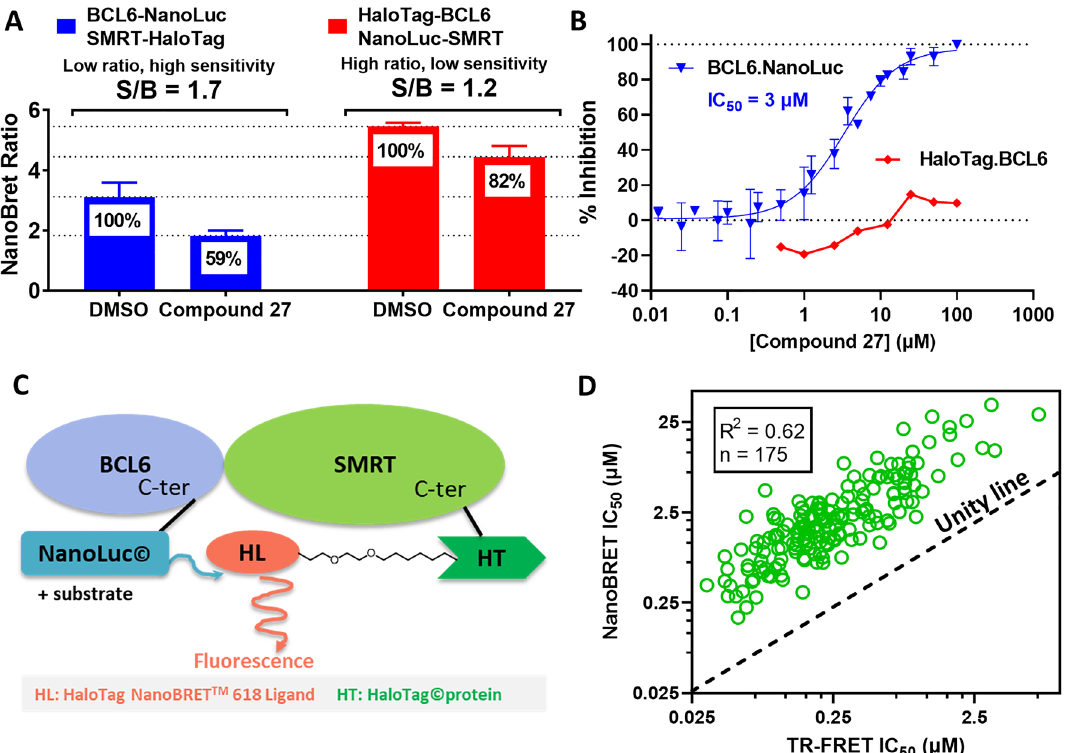
Figure 7. NanoBRET assay sensitivity and activity of benzimidazolone compounds. ( A ) Effect of the NanoBRET configuration on the assay sensitivity to compound inhibition in HEK293T cells. The blue histograms show the NanoBRET ratio for the C -terminally NanoLuc tagged BCL6 and HaloTag tagged SMRT with and without the BCL6 inhibitor 27 . The red histograms show the ratio for the N -terminally HaloTag tagged BCL6 and NanoLuc tagged SMRT with and without 27 . We selected the former because of its higher sensitivity to compound inhibition after 6 h treatment with 25 µM 27 . ( B ) Concentration responses for 27 in both NanoBRET configurations. An IC 50 value could be determined with C -terminally NanoLuc tagged BCL6 (blue triangles), but not when BCL6 was tagged N -terminally with the Halo-Tag (red diamonds). ( C ) Schematic representation of the optimal NanoBRET configuration for maximal sensitivity to compound inhibition. ( D ) Plot showing the correlation (R 2 = 0.62, n = 175) between biochemical (TR-FRET IC 50 on x-axis) and cellular (NanoBRET IC 50 on y-axis) activities of inhibitors from the benzimidazolone series. Data points are above the unity line (black), indicating cellular activities were on average an order of magnitude lower than biochemical